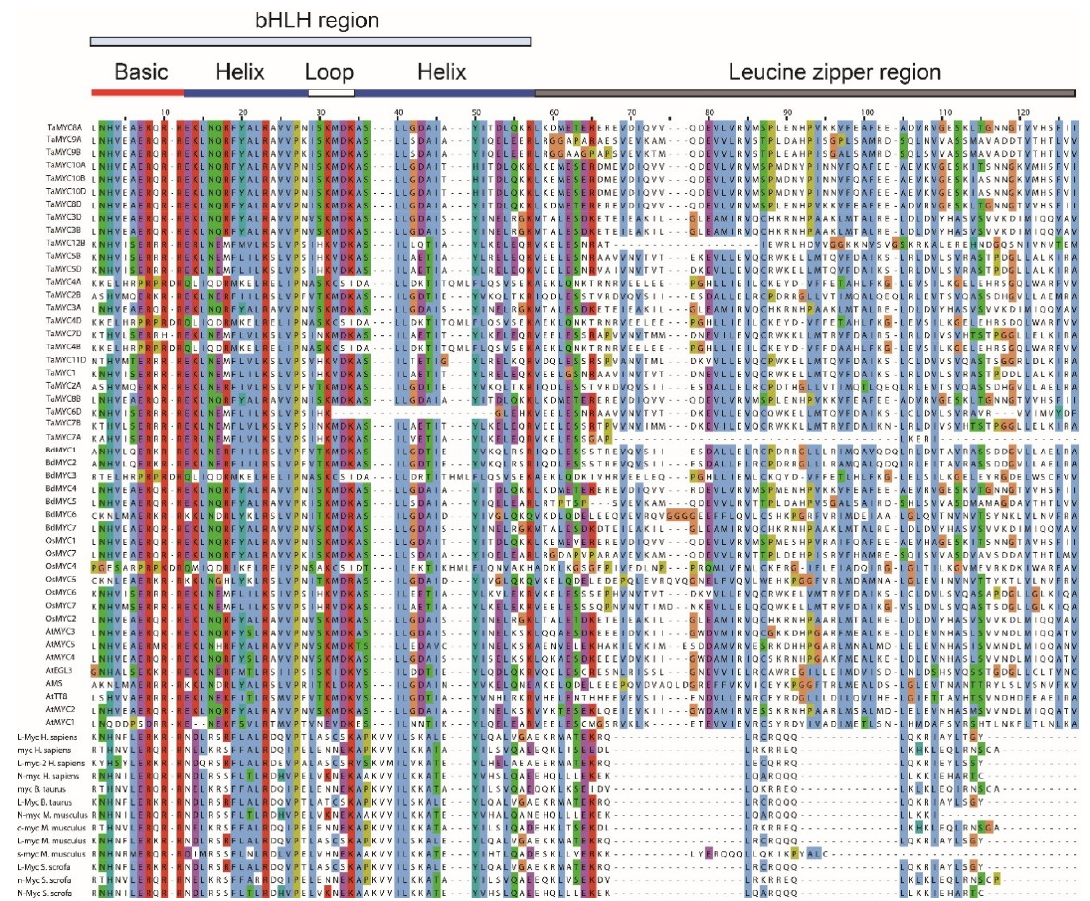
Figure 2. Alignment of the 61 different myelocytomatosis oncogenes (MYC) proteins from plants and animals. Including 40 MYCs in this study, 8 Arabidopsis MYCs, and 13 animal MYCs proteins from previous studies as described above.